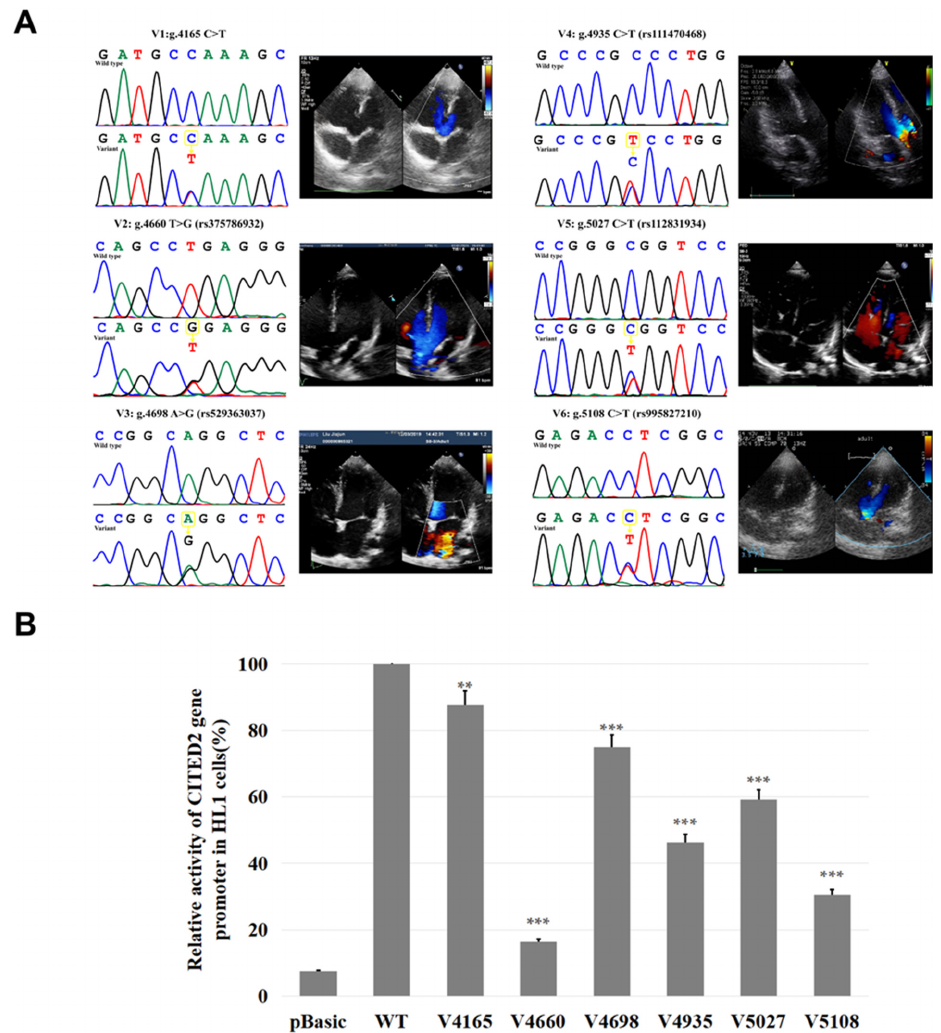
Figure 3. Sanger sequencing maps and color doppler echocardiography of variants. ( A ) The variants (V1-V6) of the CITED2 gene promoter found only in patients with TOF are shown [g.4165C>T, g.4660T>G(rs375786932), g.4698A>G(rs529363037), g.4935C>T(rs111470468), g.5108C>T (rs995827210), g.5027C>T (rs112831934)]. The top panel of V1–V6 shows the wild type, and the bottom panel shows the variant type. Next to each sequence map is the corresponding color doppler echocardiogram of the TOF patient that shows the major findings of those patients including a large malalignment ventricular septal defect and aortic overriding. ( B ) Relative transcriptional activity of the CITED2 gene promoter in HL-1 cells. The transcriptional activity of the wild-type CITED2 gene promoter was set as 100%, and the relative activity of the variants were calculated. Results are presented as the mean ± SD of three independent experiments, each in triplicate. Basic: empty vector; WT: wild type; V1: pGL3-4165T, V2: pGL3-4660G, V3: pGL3-4698G, V4: pGL3-4935C>T, V5: pGL3-4698G, V6: pGL3-5027C>T. **, p < 0.01; ***, p <